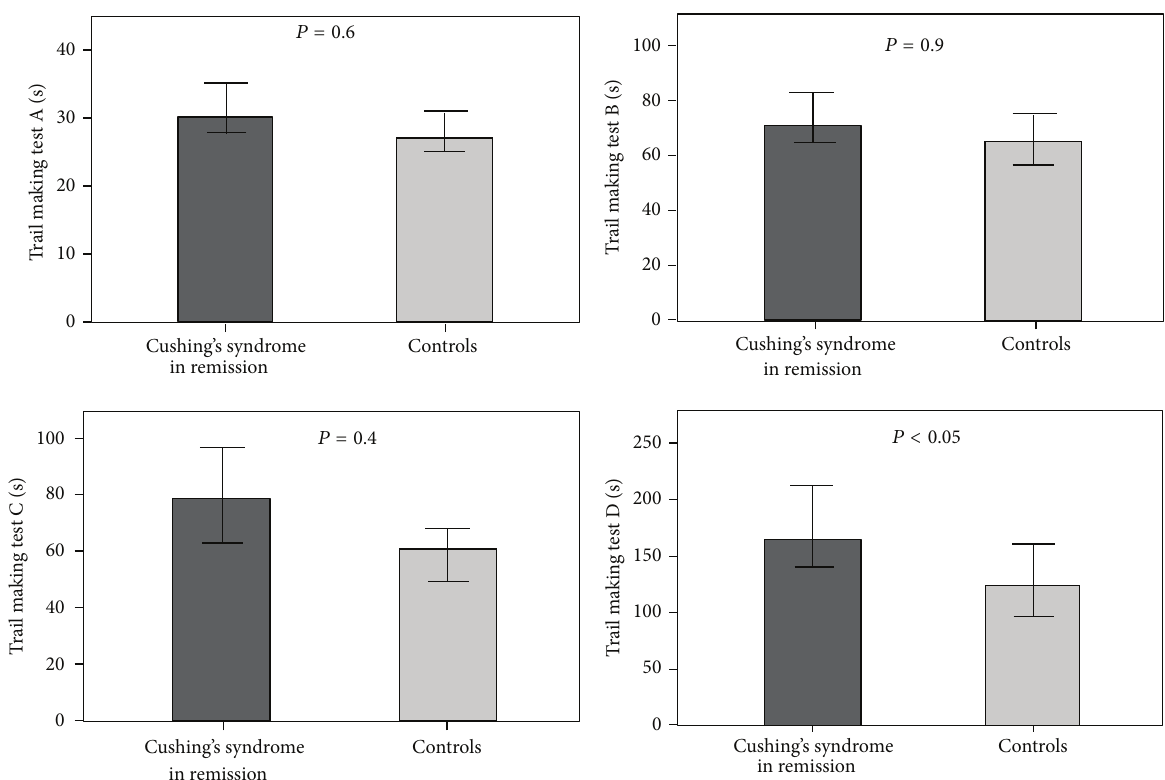
Figure 2: Bar charts showing the median time in seconds (95% confidence interval) on TMT parts A, B, C, and D in 51 patients with CS in remission (dark grey bars) and 51 controls matched for gender, age, and educational level (light grey bars). The 𝑃 values are obtained by multiple linear regression analysis after adjustment for fatigue and scores for depression and